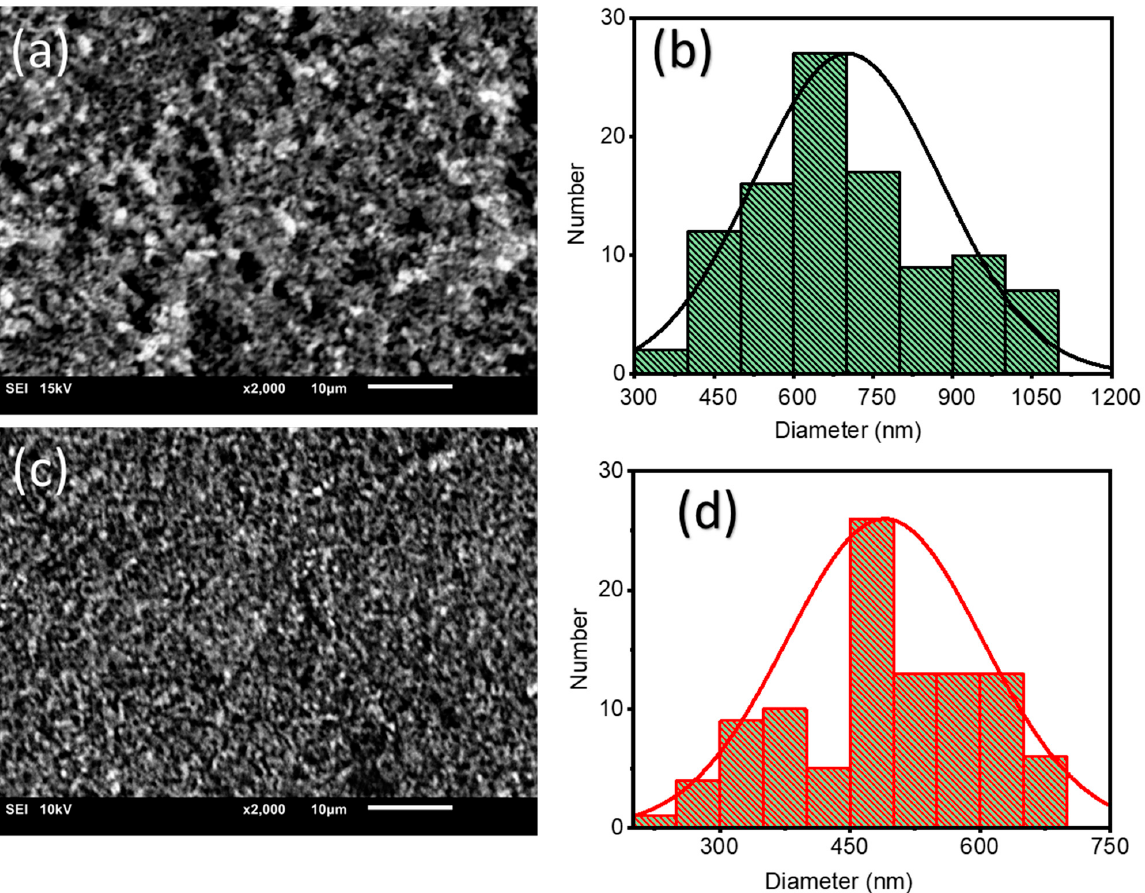
Figure 2. SEM images and cluster size distribution of the ZnO NP cluster at ( a ), ( b ) 10 µm scale (without dye extracts) and ( c ), ( d ) 10 µm scale (with A. indica dye extracts).